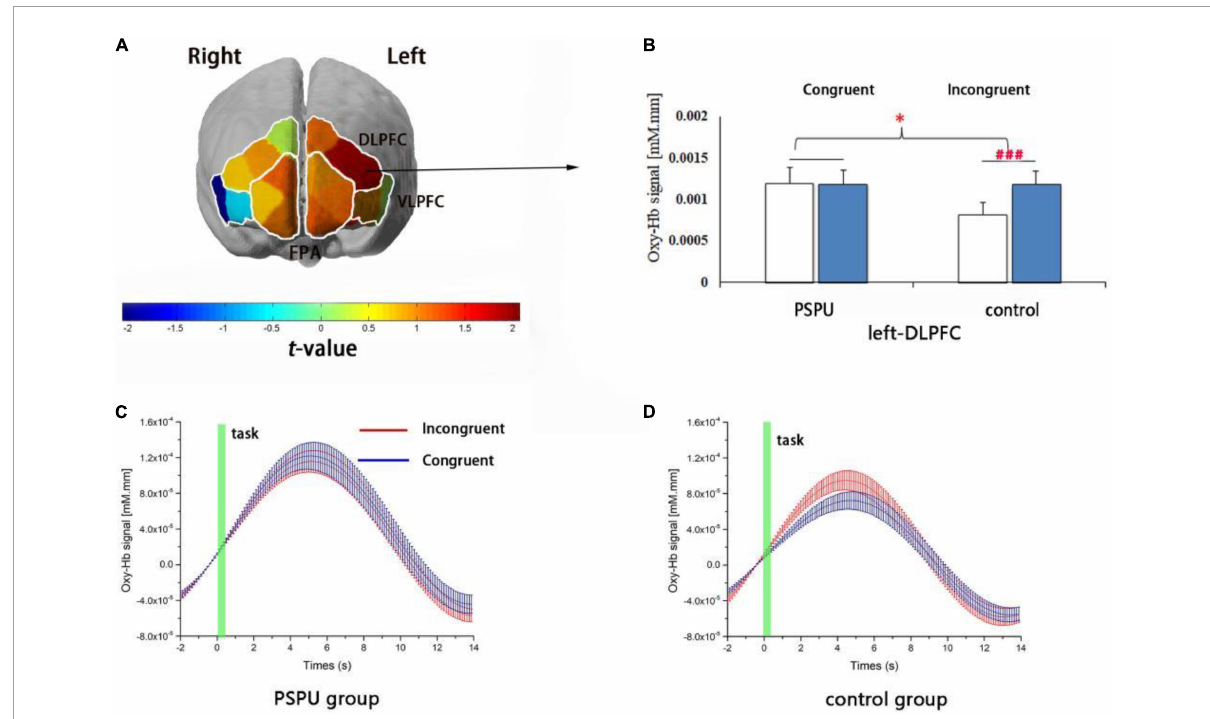
FIGURE4 Cortical activation in relation to the effect of Stroop interference. (A) t-map of changes in Oxy-Hb signals that reflect the effect of Stroop interference. Significant differences between the PSPU and control groups are observed in the left-DLPFC ( p = 0.02, FDR controlled) using the six regions of interest. (B) Changes in individual Stroop task-related Oxy-Hb levels in the left-DLPFC. Oxy-Hb hemodynamic alterations due to incongruent tasks are significantly higher than congruent tasks only in the control group ( p < 0.001). (C,D) depict the timelines of Oxy-Hb changes in their response to congruent and incongruent tasks within the left-DLPFC involving the PSPU and control groups,